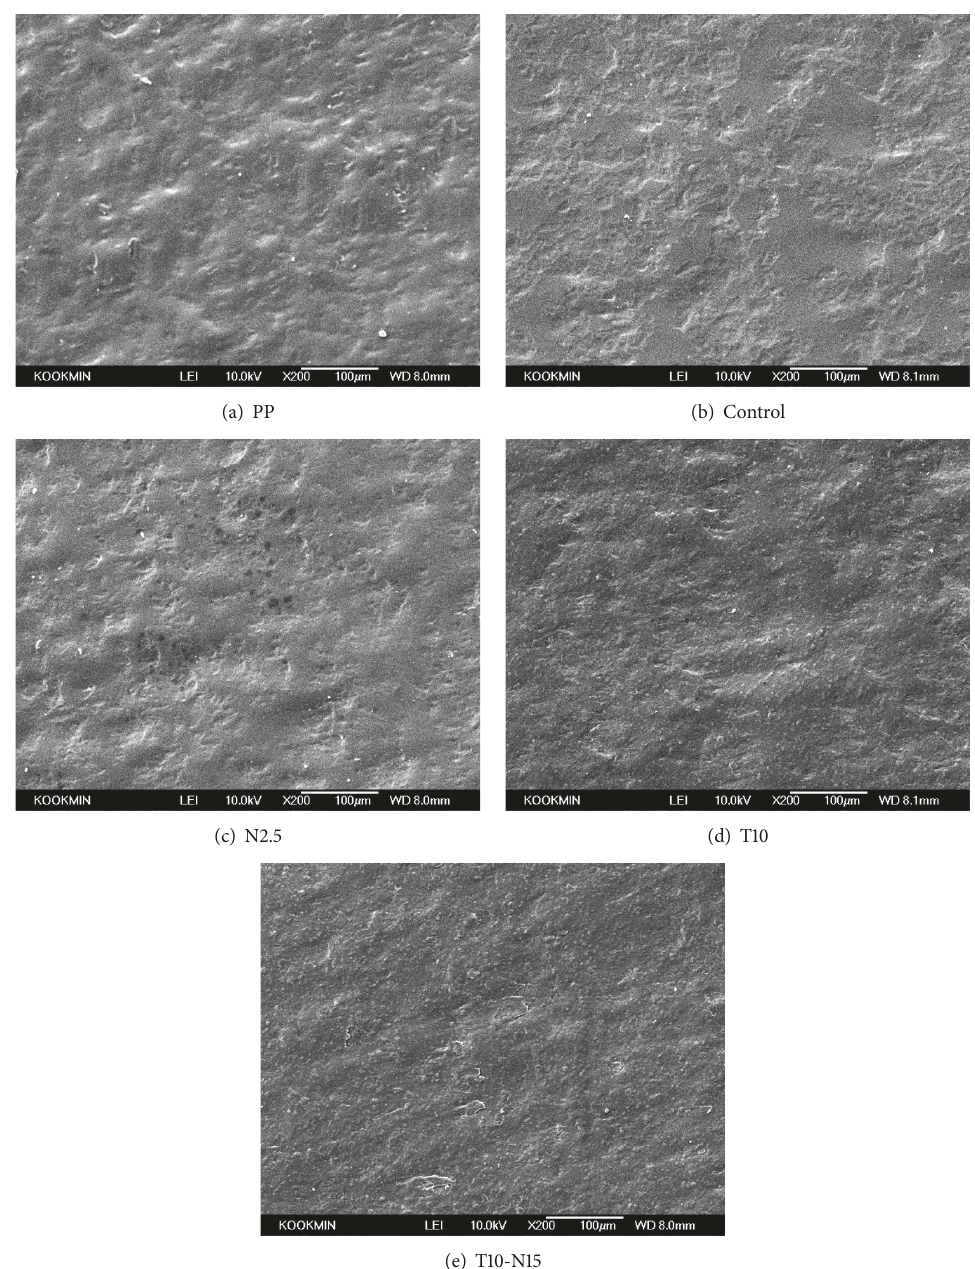
Figure 5: SEM images of pure PP, control, NCC-only, and NCC-talc hybrid filled PP-based composites before accelerated weathering test.